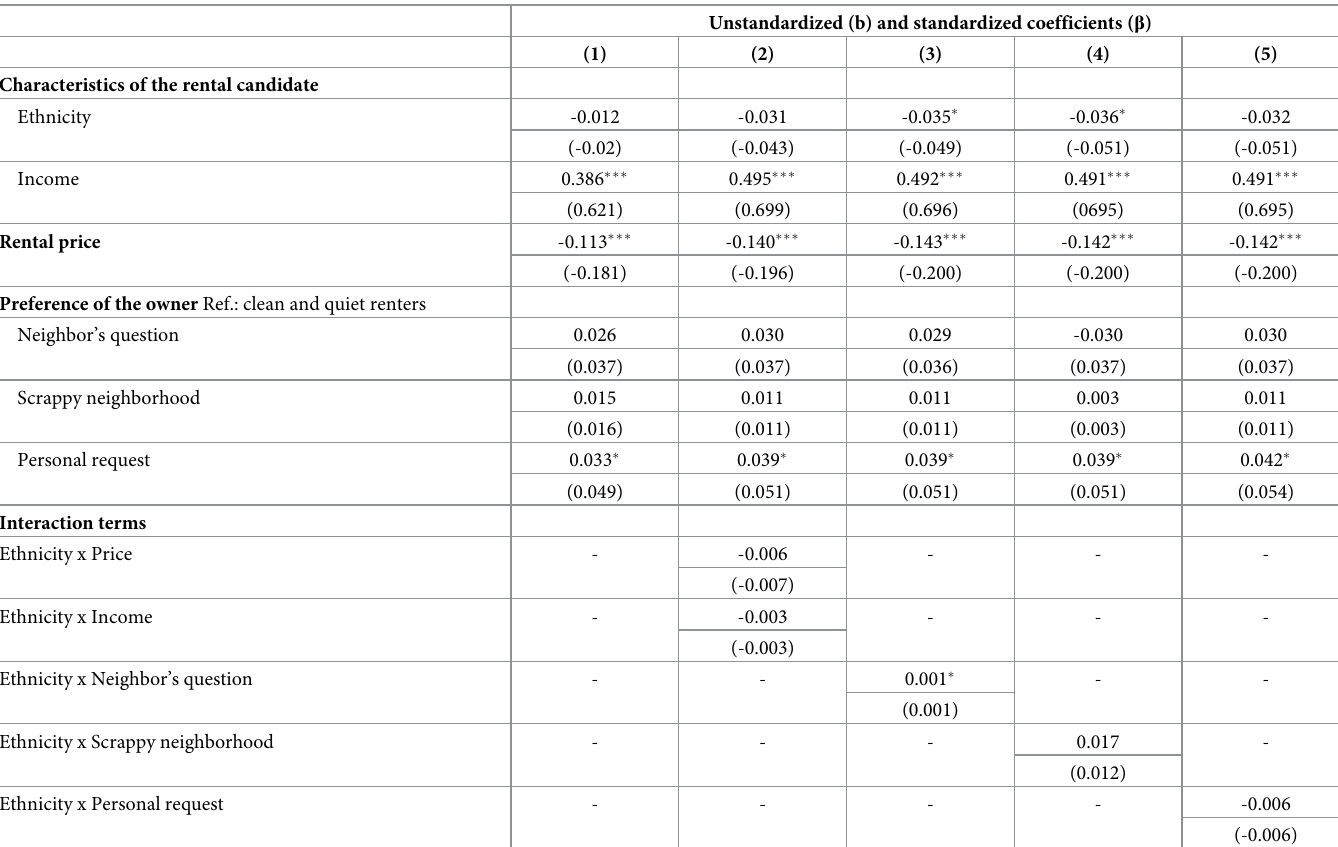
Table 6. Linear regression analyses of the statistical based